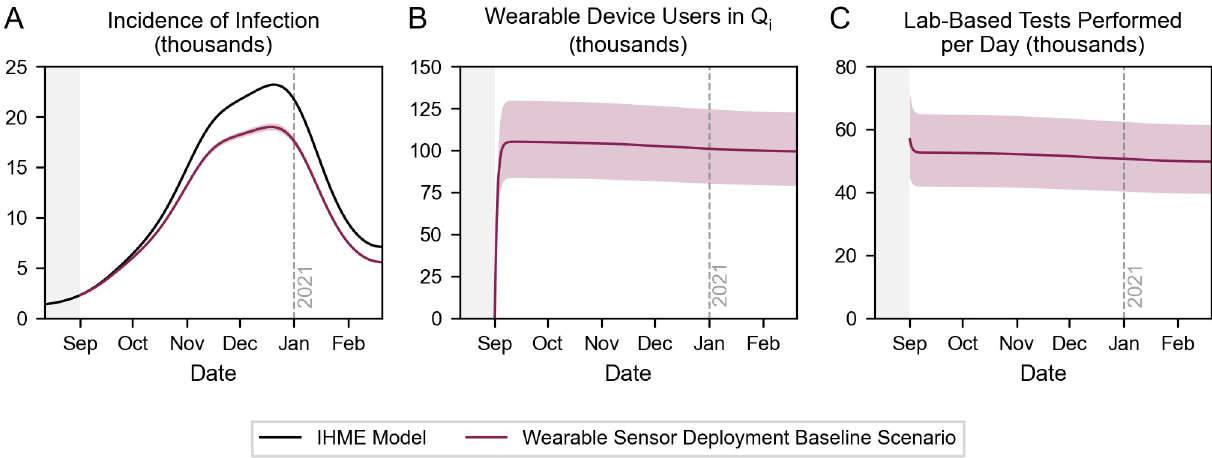
Fig 2. Baseline scenario for wearable sensor deployment. Time series depiction of (A) the incidence of infection, (B) the number of wearable device users incorrectly in quarantine, and (C) the daily demand for lab-based tests. Uptake, adherence, detection sensitivity, and detection specificity are set to 4%, 50%, 80%, and 92%,